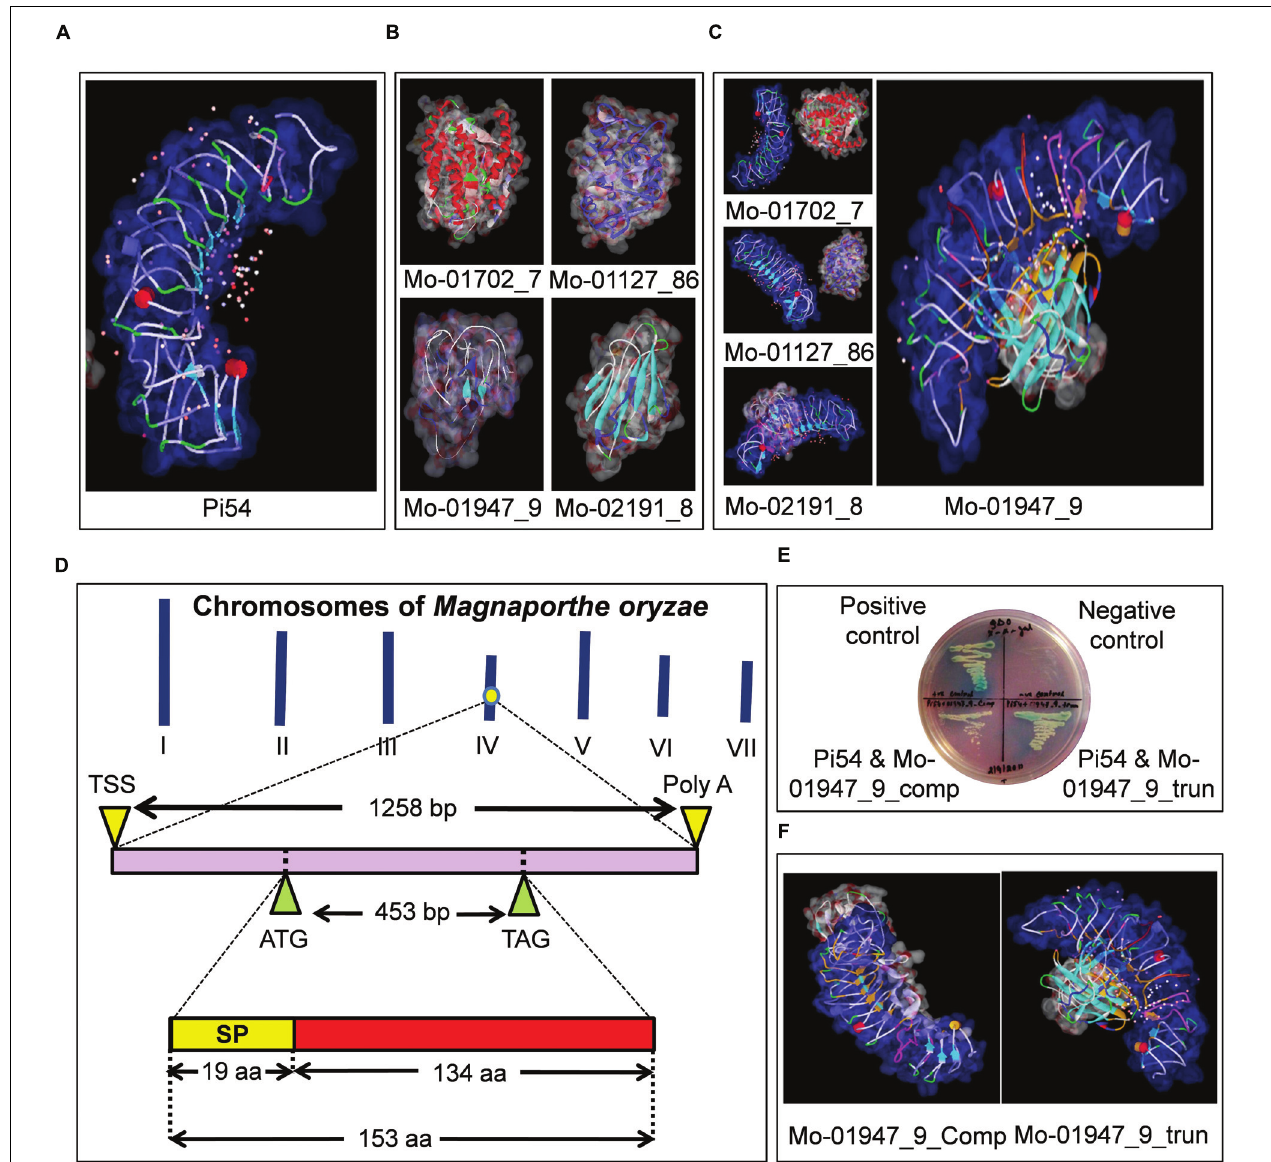
FIGURE 2 | Identification of AvrPi54 gene in Magnaporthe oryzae genome which encodes a secreted protein, that interacts with blast resistance protein Pi54. 3-D models of Pi54 protein (A) and candidate AvrPi54 proteins (B) generated by MODELER software inbuilt in Accelrys Discovery Studio 2.1. In silico interaction study between Pi54 protein and the four selected candidate AvrPi54 proteins by docking analysis (carried out in ZDOCK software inbuilt in Accelrys Discovery Studio 2.1) revealed, Mo-01947_9 protein is the best candidate to be qualified as AvrPi54 protein as it showed best interaction with Pi54 protein. The Pi54 protein is shown in blue in all the cases and the interacting amino acids of both Pi54 and candidate AvrPi54 proteins are shown in orange (C) . In silico mapping showed that the candidate AvrPi54 (Mo-01947_9) is a unique gene located at chromosome 4. It is a 1258 bp long gene containing a single unfragmented ORF of 462 bp. It encodes a protein consisting of 153 amino acids among which first 19 amino acids from the N-terminal end encodes for a signal peptide (SP) needed for secretion (D) . Yeast-2-Hybrid analysis confirmed the interaction between Pi54 protein and candidate AvrPi54 protein (Mo-01947_9) in vitro . Interaction potential was checked for both full length (Mo-01947_9_comp) as well as SP truncated version (Mo-01947_9_trun) of candidate AvrPi54 protein with the Pi54 protein. Better growth of yeast cells clearly suggested better interaction potential of SP truncated version (Mo-01947_9_trun) of candidate AvrPi54 protein with Pi54